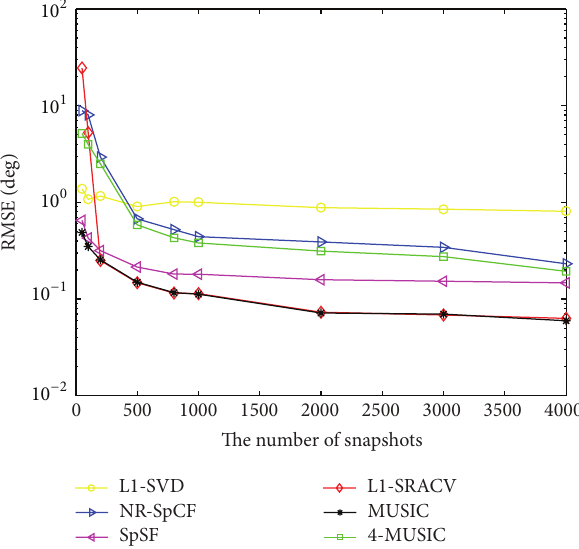
Figure 5: The RMSE versus the number of snapshots for the six